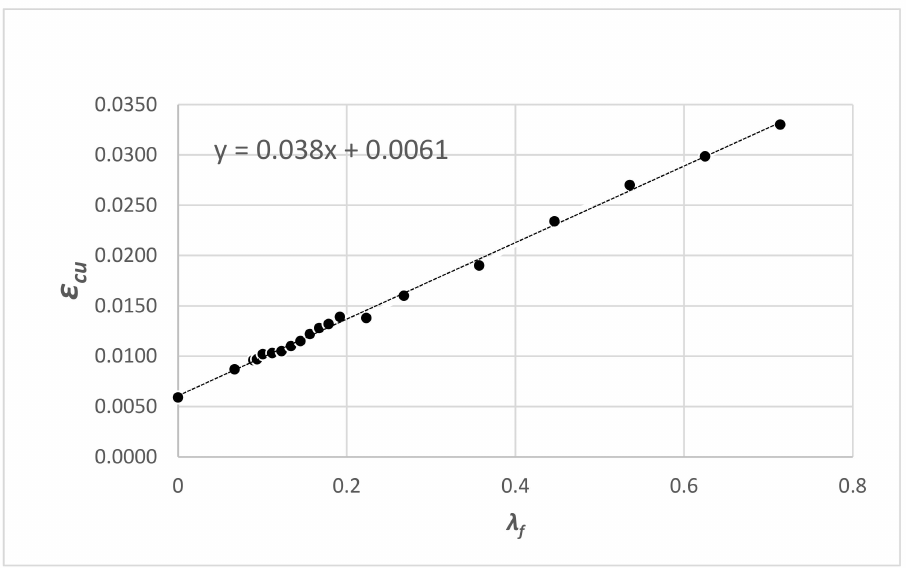
Figure 11. The relation between the ultimate strain in concrete and confinement